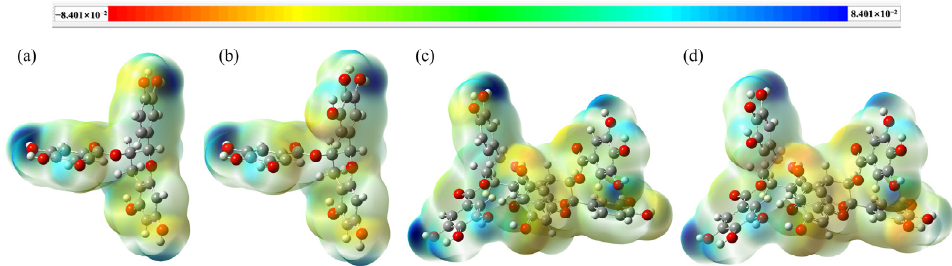
Figure 4. The MEP diagrams of the four characteristic structural units from PT: ( a ) ECG, ( b ) EGCG, ( c ) A − ECG dimer, ( d ) A − EGCG dimer. ( c ) A − ECG dimer, ( d ) A − EGCG dimer.